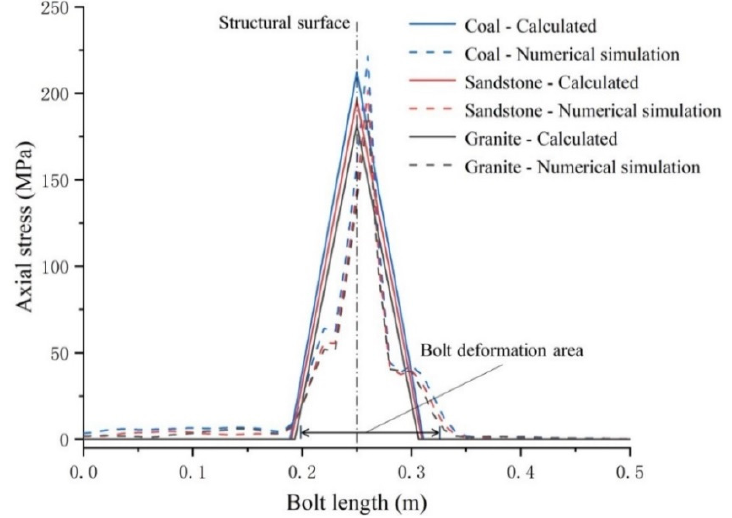
Figure 14. Diagram of axial stress distribution along bolt length.